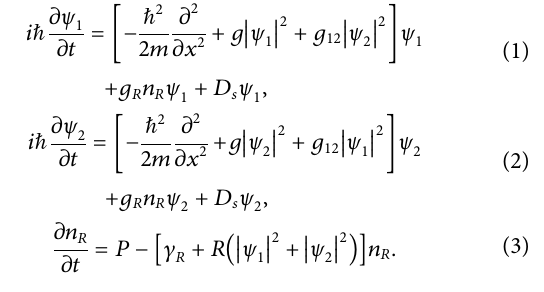
Frontiers in Physics |